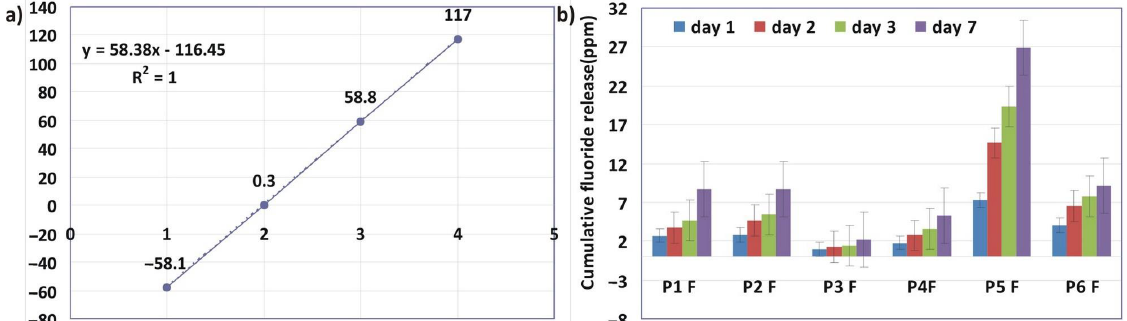
Figure 4. ( a ) The calibration curve of fluoride ions and ( b ) the cumulative fluoride release distribu- tion over time for P1F – P6F experimental infiltrants .